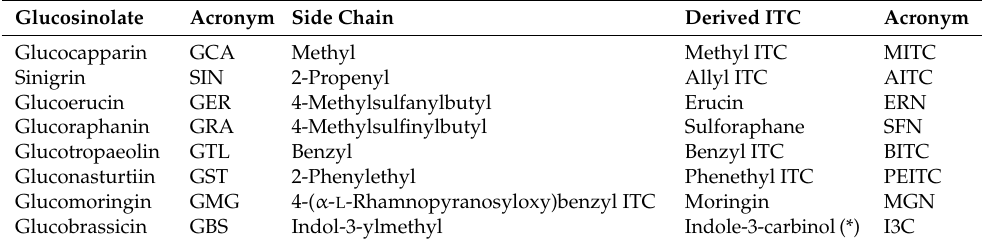
Table 1. Most investigated bio-active ITCs and other hydrolysis products from